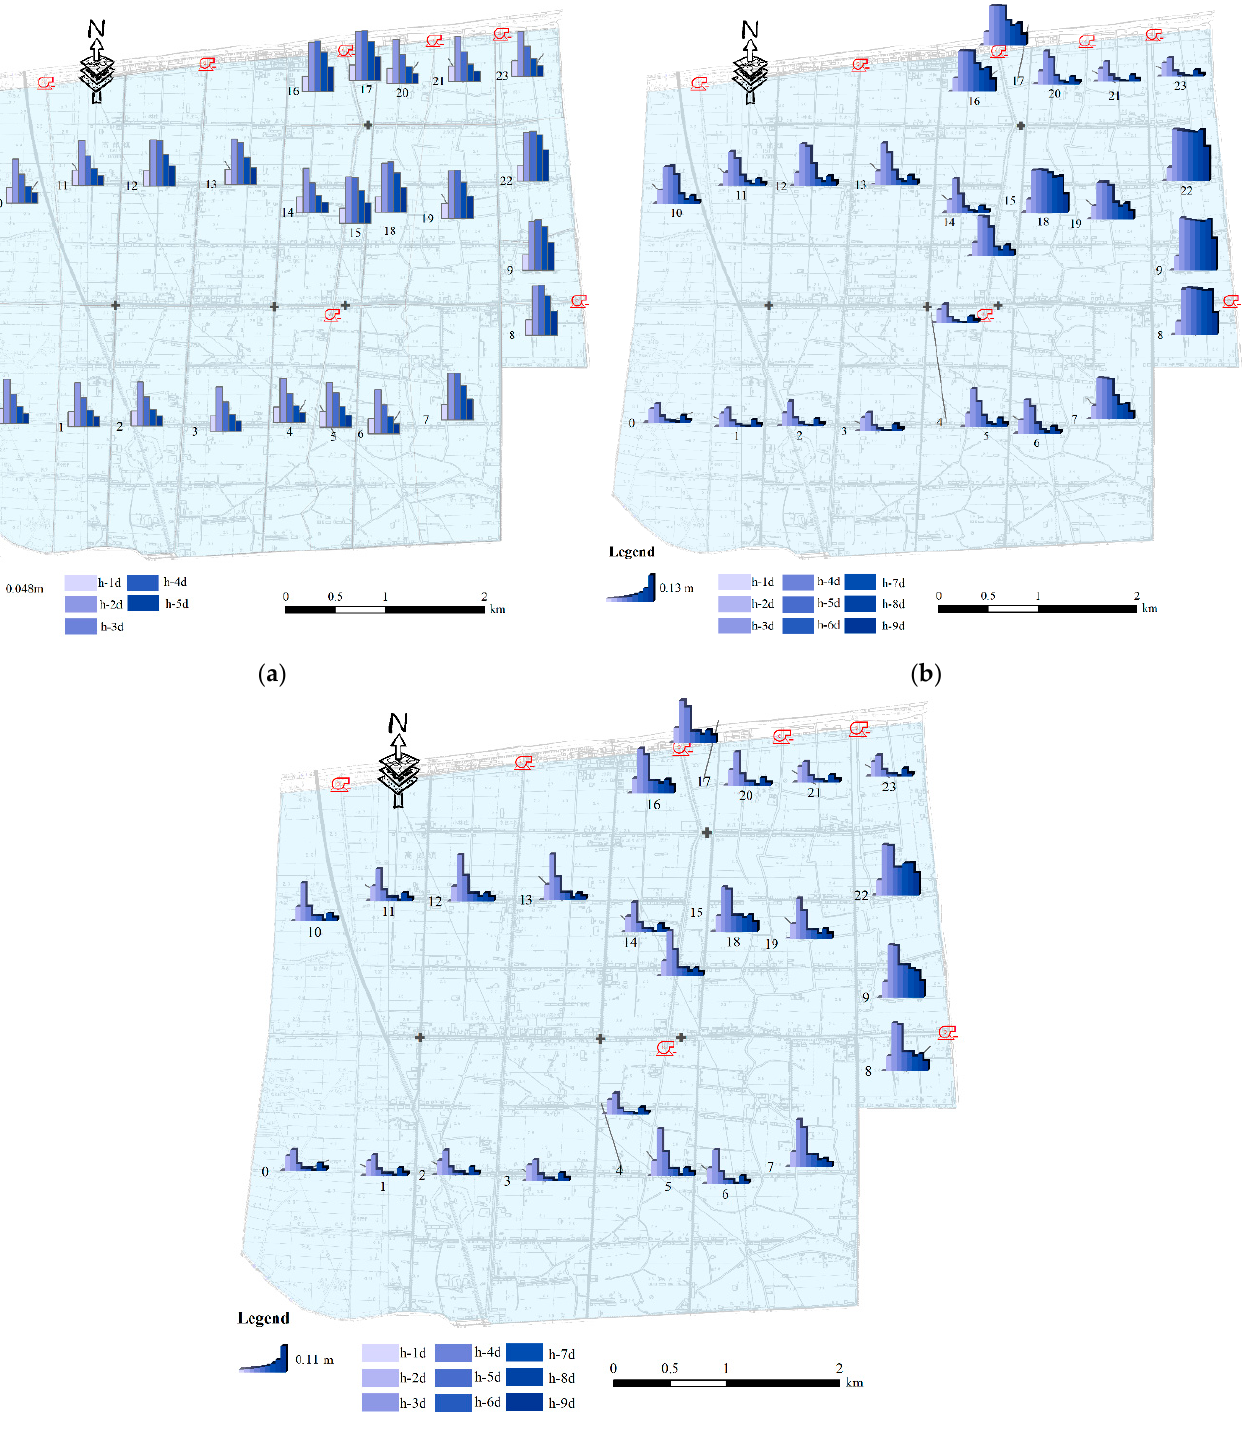
Figure 8. Distribution and process of flooding water depth and reduction in water level for the optimized scheme. ( a ) Inundated water depth in Rainfall Event 1. ( b ) Inundated water depth for optimized scheme in Rainfall Event 2. ( c ) Reduction in inundated water depth compared with local practice in Rainfall Event 2.